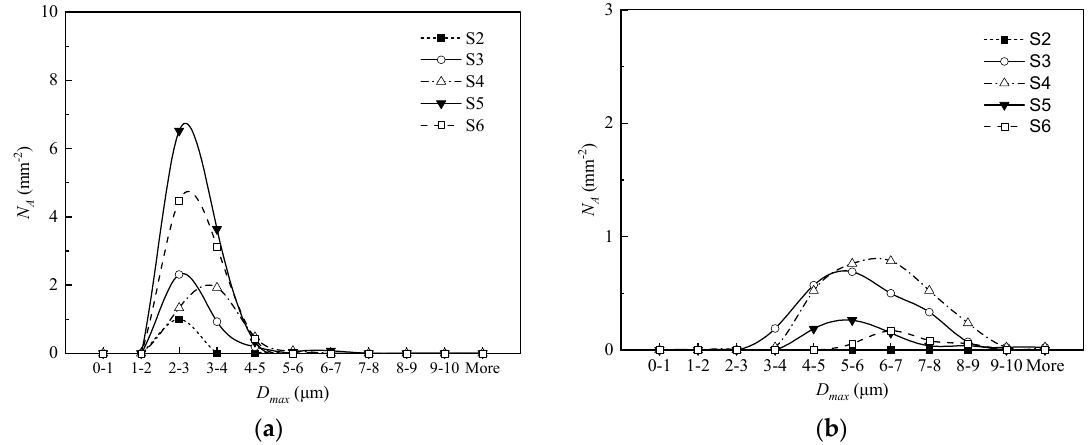
Figure 11. The size distribution of the AlN inclusions with ( a ) the plate-like and ( b ) needle shape in 533N-P steel samples.